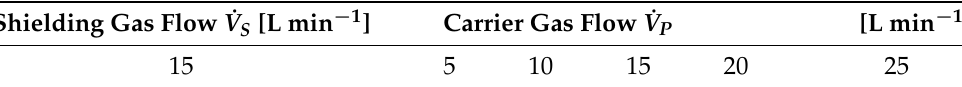
Table A1. Experimental design to investigate the influence of carrier gas flow on shielding gas